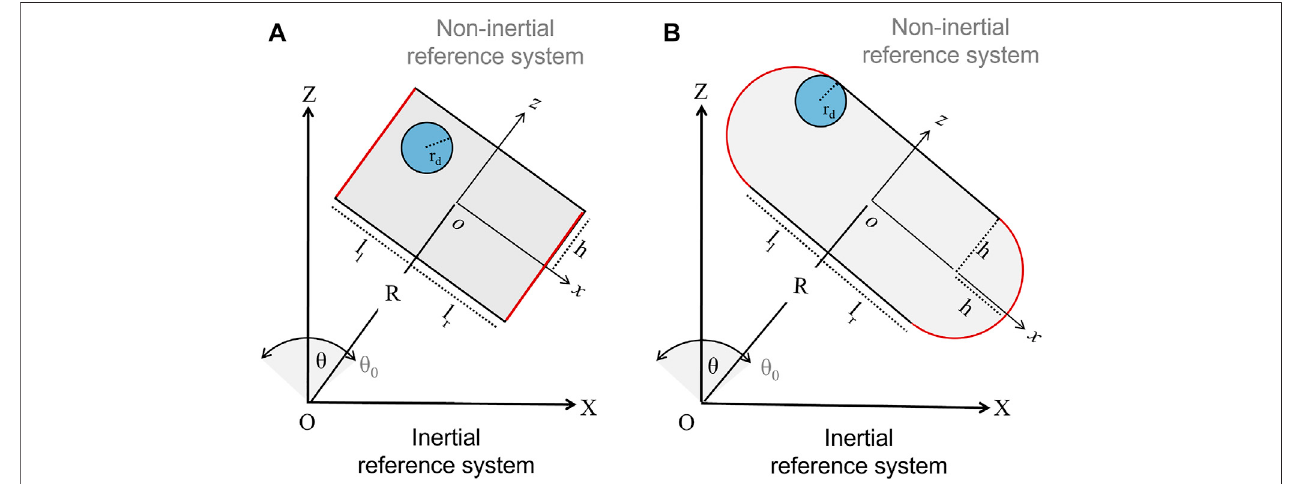
FIGURE 1 | Sketches of two 2-dimensional ball-milling devices driven by harmonic pendular motion ( X , Z ) and ( x , z ) represent the inertial and non-inertial reference frames, respectively. Panel (A) illustrates a reactor with fl at bases (in red) of width l f = l l + l r and height 2 h , sustained by a mechanical arm of length R . l l and l r regulate the distance of the arm from the reactor center, and when the left and right sides of the reactor are different, l l ≠ l r , the system experiences an asymmetric forcing. The mechanical treatment is performed by a rigid disc of radius r d . The oscillatory motion is described by the angle θ , with maximal amplitude θ 0 = π /12, and frequency ] = 18 Hz. Panel (B) shows a reactor characterized by curved bases of curvature radius h , width l c = l l + l r + 2 h and height 2 h .